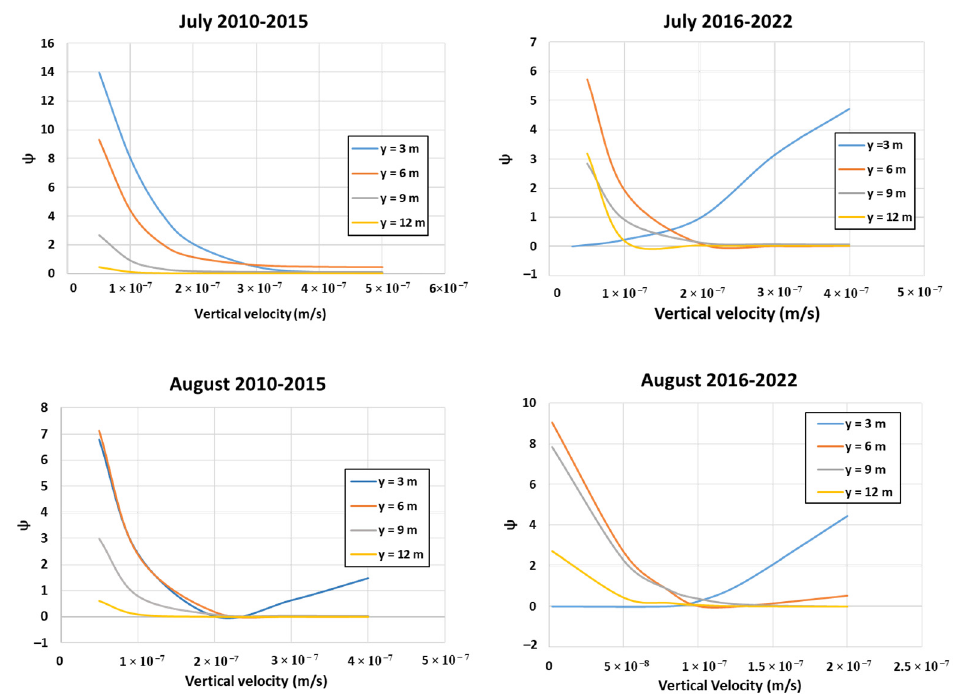
Figure 9. In fl uence of velocity on function variations ( Ψ ) for each scenario at the selected depths. Accordingly, the minimum value of the function defines the optimal velocity. Table 3 summarizes the selected values. Table 3. Selected velocities for every depth according to the protocol in P-I. The symbol [*] refers to the results of limited reliability.